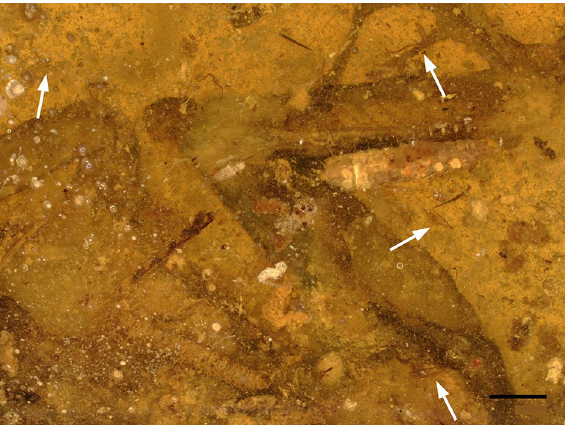
Figure 6. Amber piece Number GRS-Ref-060905. The Picture shows the ventral, left side of a lizard portion, primarily the hind leg, probably of the family Agamidae. Four white arrows show wings and legs of flies of the family Phoridae. Scale bar 1